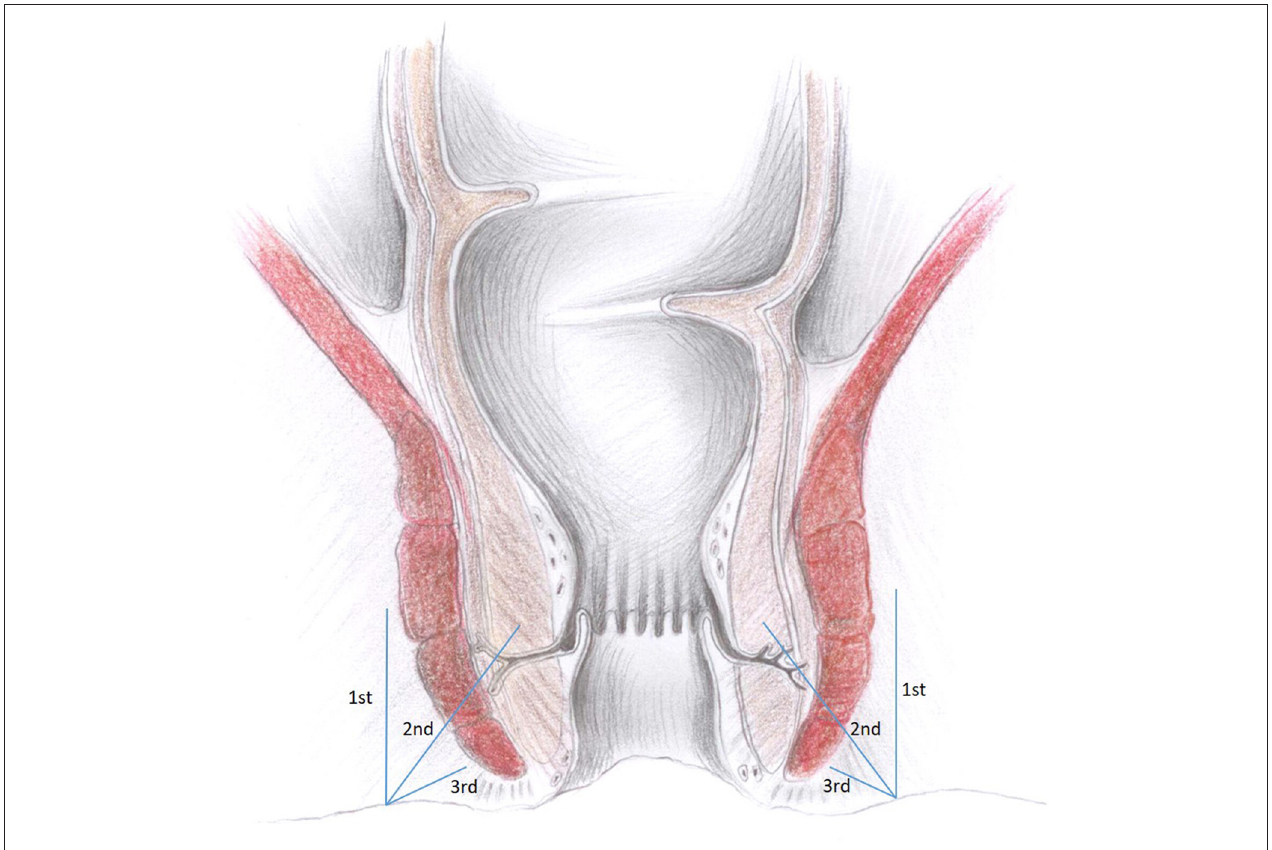
FIGURE 1 | Directions of all anesthetic injections visualized in the frontal plane.